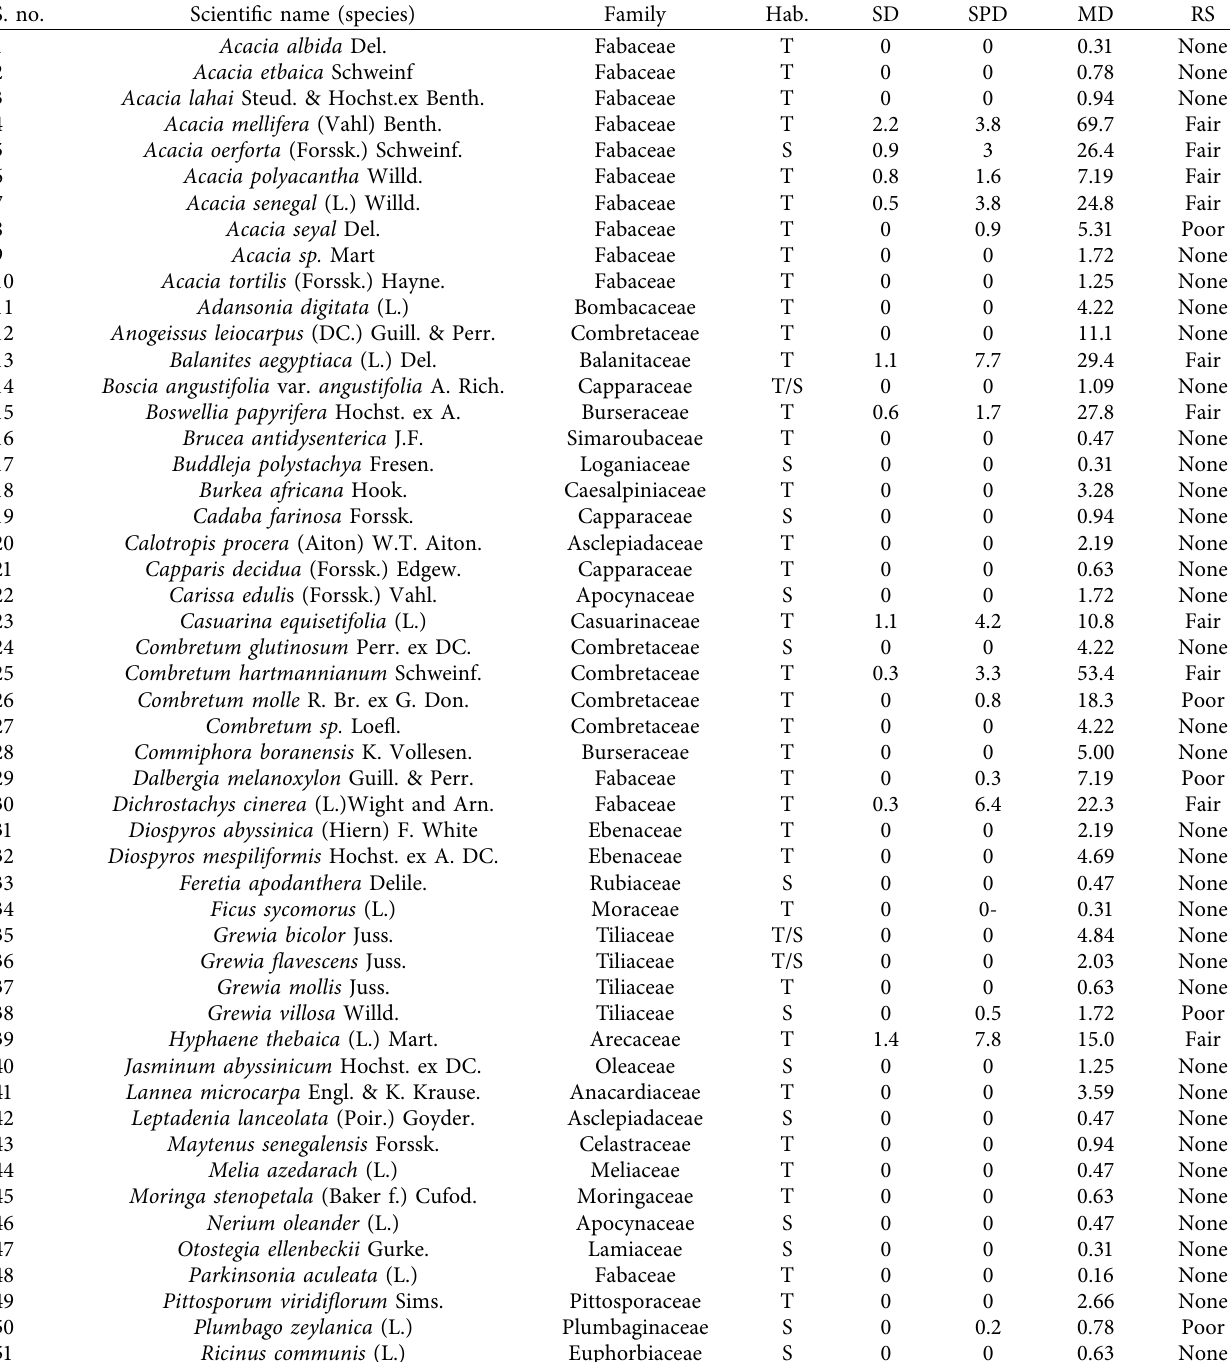
Table 2: Natural regeneration status of woody species in Kafta Sheraro National Park. S.